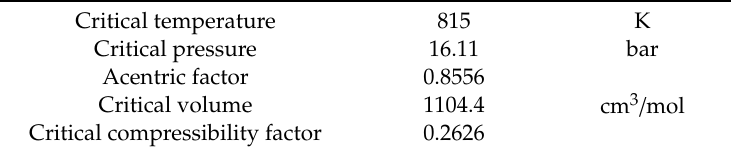
Table 3. Critical properties for the ionic liquid [hmim][Tf 2